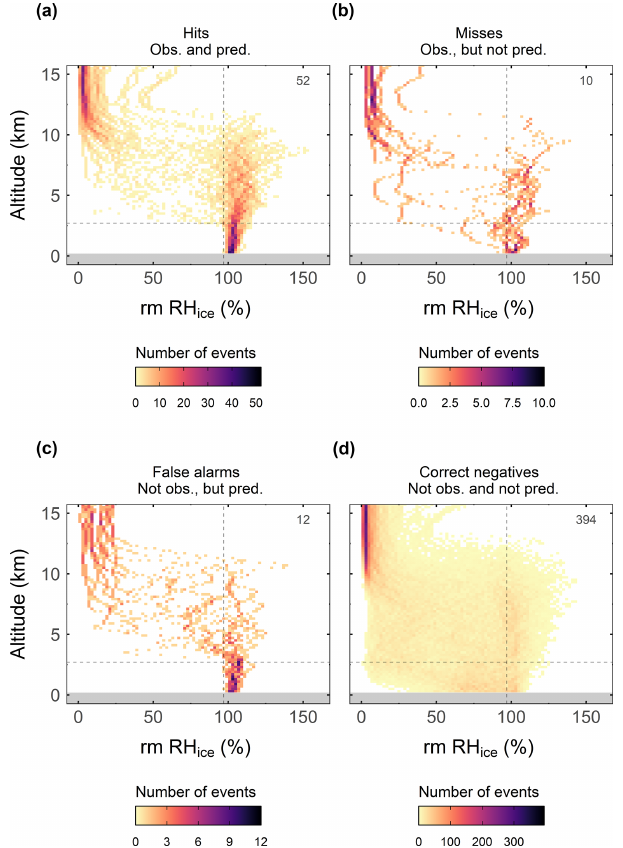
Figure 7. Observed values of running mean RH ice binned in 200m intervals and 2% steps of RH ice for (a) hits , (b) misses , (c) false alarms , and (d) correct negatives . Snowfall was predicted for cases when running mean RH ice measured along the radiosonde profile was ≥ 97% (vertical dashed line) throughout the lower 2.7km (hor- izontal dashed line) of the atmosphere. The total number of events per group is shown in the upper right corner of each panel. The colour scale ranges from zero to the total number of events for each group, so the colour scale for each panel is different.